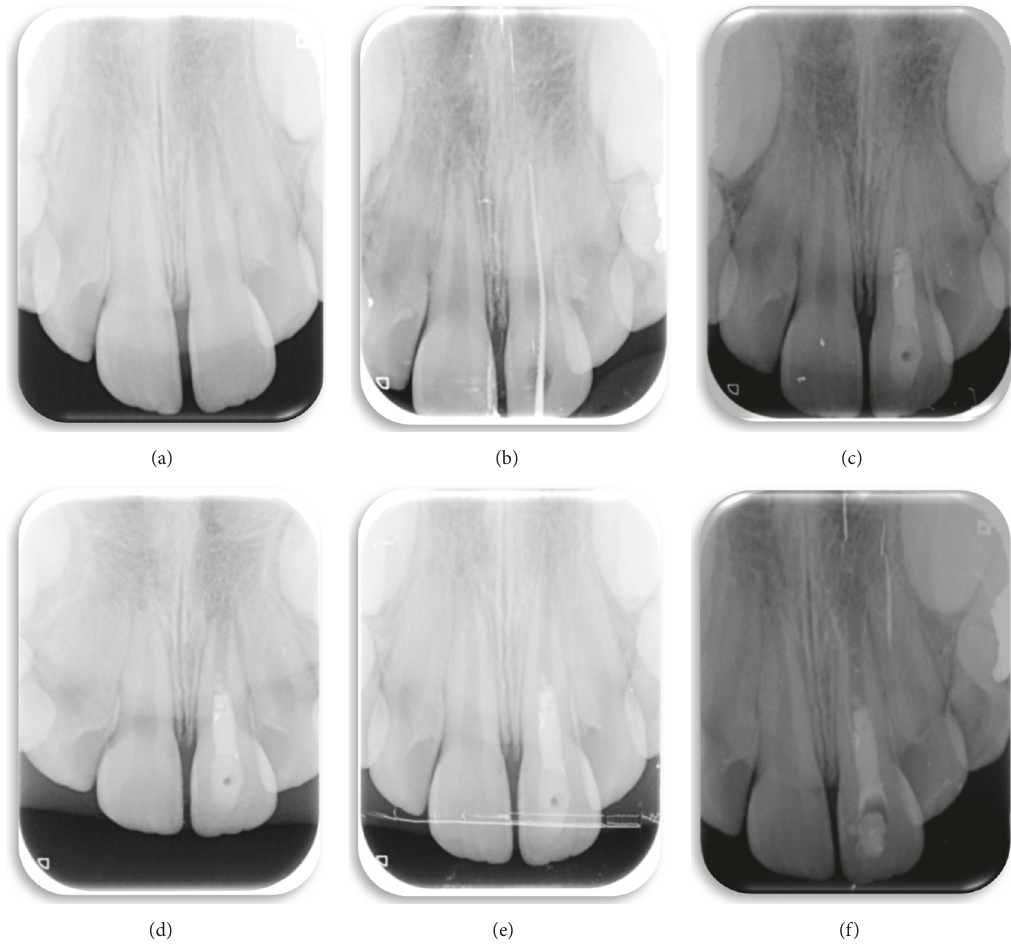
Figure 2: (a) Periapical radiograph image, 6 months after a trauma-induced subluxation of tooth 21, shows open apex of more than 2 mm, with periapical radiotranslucency. (b) Start of revascularization treatment of tooth 21, determination of working length. (c) Chamber sealed with MTA and wet cotton pellets, waiting for it to set hard. (d) Follow-up radiograph at 3 months, the periapical radiotranslucency at tooth 21 has disappeared. (e) Seven months after completion of revascularization therapy, dentinal wall thickening can be observed at 21, with the consequent narrowing of the apical foramen. (f) One year and 7 months after completion of revascularization treatment and compared with the periapical radiograph taken when revascularization treatment ended, there is a noticeable increase in root length, similar to the adjacent central incisor, thickening of the root walls, and a closed